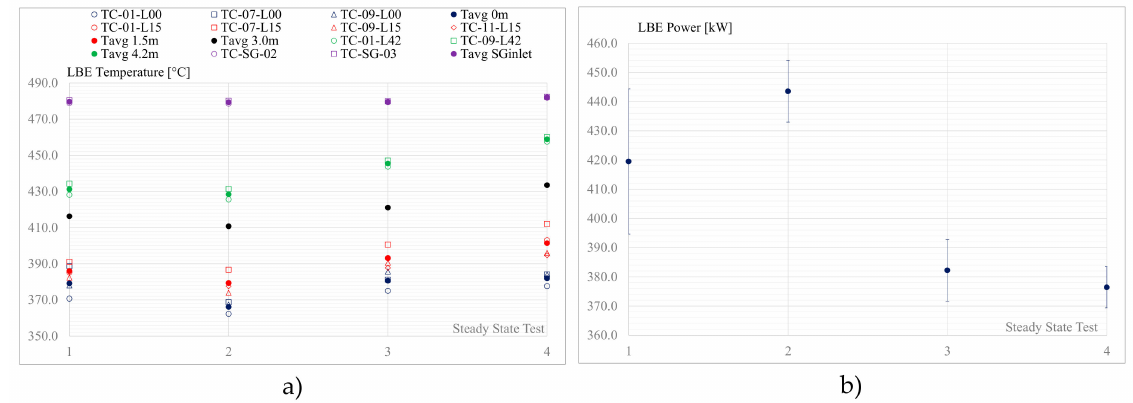
Figure 9. EF-T5: ( a ) LBE temperatures along the SG shell side for all the steady states; ( b ) LBE power and relative standard deviation at steady